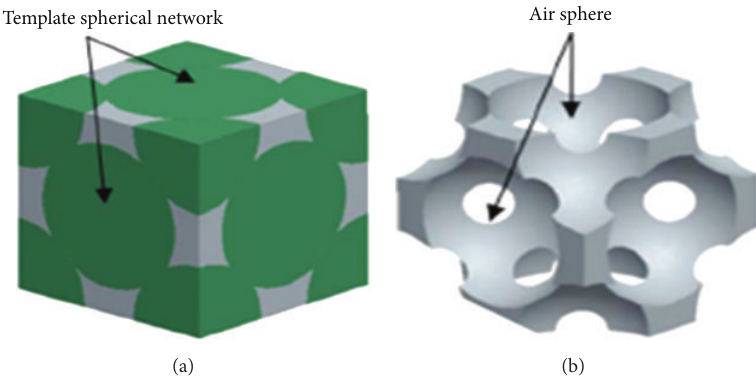
Figure 10: Unit cell of an infiltrated opal (a); unit cell of an inverse opal (b) [66].